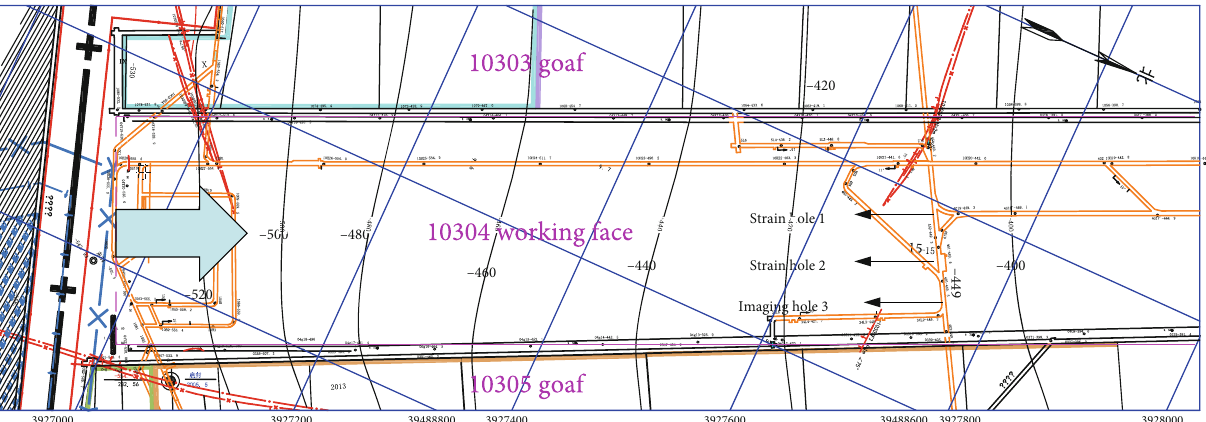
Figure 3: Panel 10304 borehole layout.